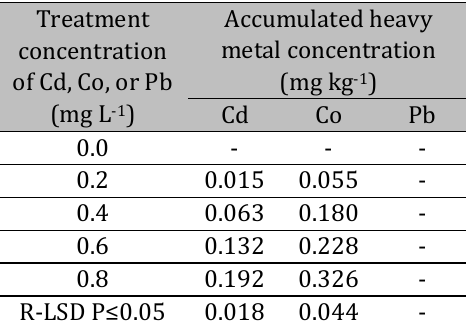
Table 1. In vitro accumulation of cadmium, cobalt, and lead in the vegetative parts of the big-sage plant.